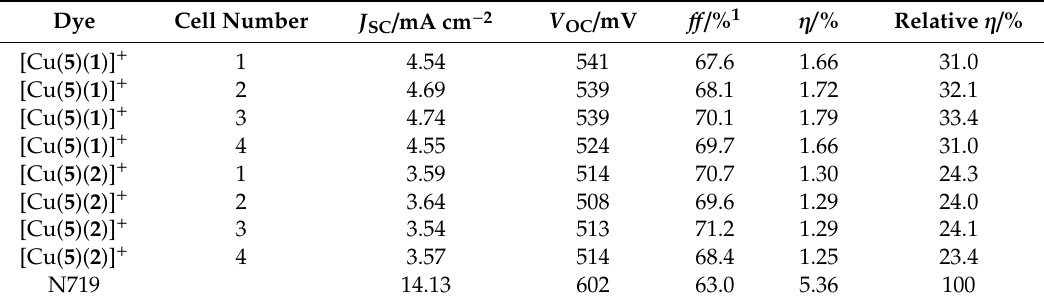
Figure 7. J–V ( J = current density, V = voltage) curves for sets of four dye-sensitized solar cells (DSCs) sensitized with [Cu( 5 )( 1 )] + (blue curves) and [Cu( 5 )( 2 )] + (red curves) measured on the day of sealing the cells. Table 1. Performance parameters (under 1 sun illumination) of duplicate, masked DSCs on the day of sealing the cells with the dyes [Cu( 5 )( 1 )] + and [Cu( 5 )( 2 )] + . The data are compared to a DSC containing N719 and relative η values are with respect to N719 set at 100%.